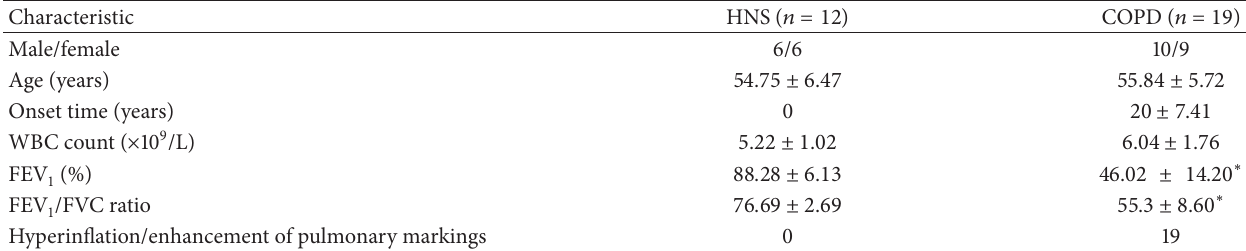
Table 1: Clinical and laboratory characteristics of the COPD patients and